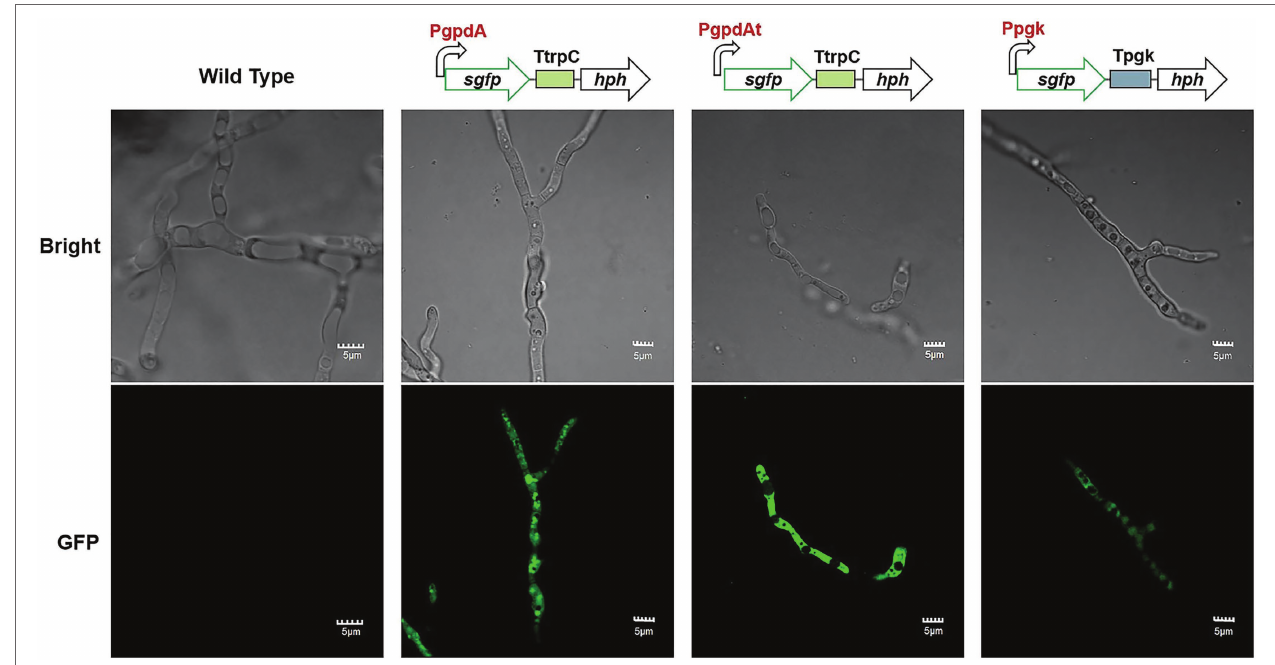
FIGURE 4 | Microscopic features of wild type and representative mutant strains with promoters of PgpdA , PgpdAt , and Ppgk . Bright: Bright-field images. GFP: Fluorescence images. All scale bars represent 5 μ